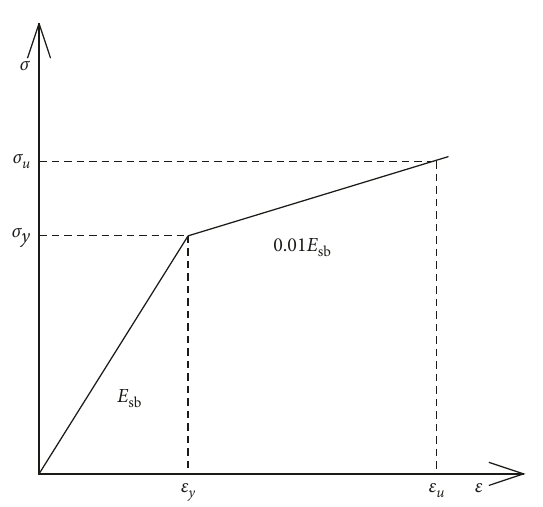
Figure 11: Stress-strain relationship in the catenary stage.